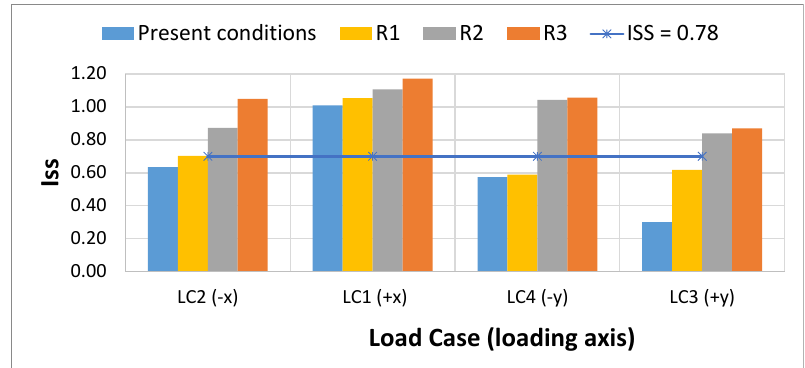
Figure 16. Seismic safety index for the present conditions and for the three retrofit interventions.